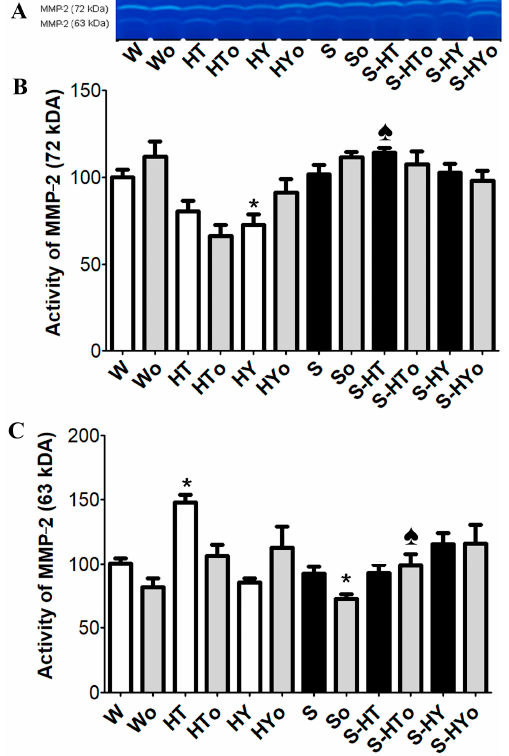
Figure 8. Zymography of matrix metalloproteinase-2 (MMP-2) and quantitative analysis of MMP-2 activity in the male normotensive and hypertensive rats with altered thyroid status with or without feeding with Omacor. 72 kDa pro-MMP-2 ( A , B ); 63 kDa active MMP-2 ( A , C ); W—Wistar Kyoto euthyroid control rats; o—fed with Omacor; HT—hyperthyroid rats; HY—hypothyroid rats; S—spontaneously hypertensive rats; n = 6 in each group. Data are presented as means ± SD; * p < 0.05 vs. W; ♠ p < 0.05 HT vs. S-HT/ HY vs. S-HY. Int. J. Mol. Sci. 2019 , 20 , x FOR PEER REVIEW